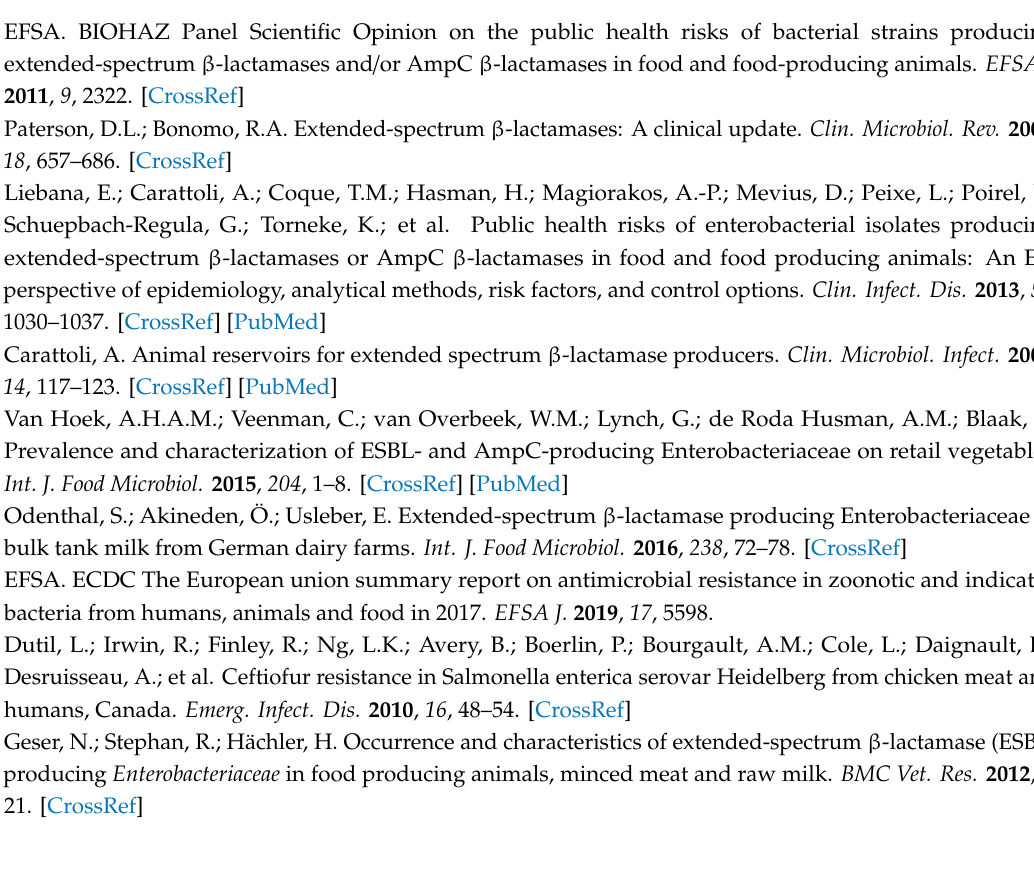
Table S1: Genetic characteristics and antimicrobial susceptibilities of ESBL-producing E.coli from human and food